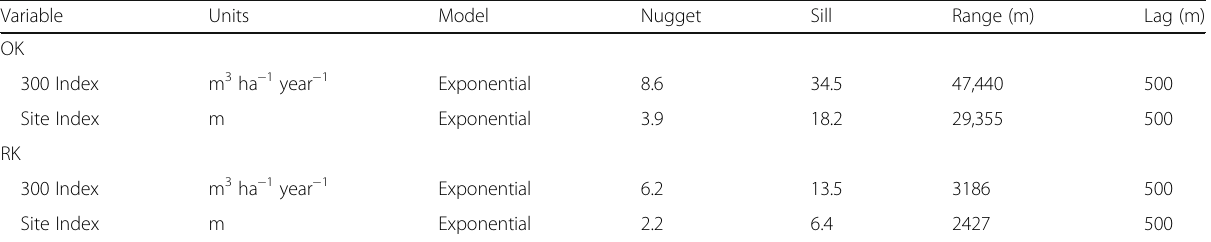
Table 2 Coefficients of the models fitted to semivariograms for ordinary kriging (OK) and PLS regression kriging (RK) models for the 300 Index and Site